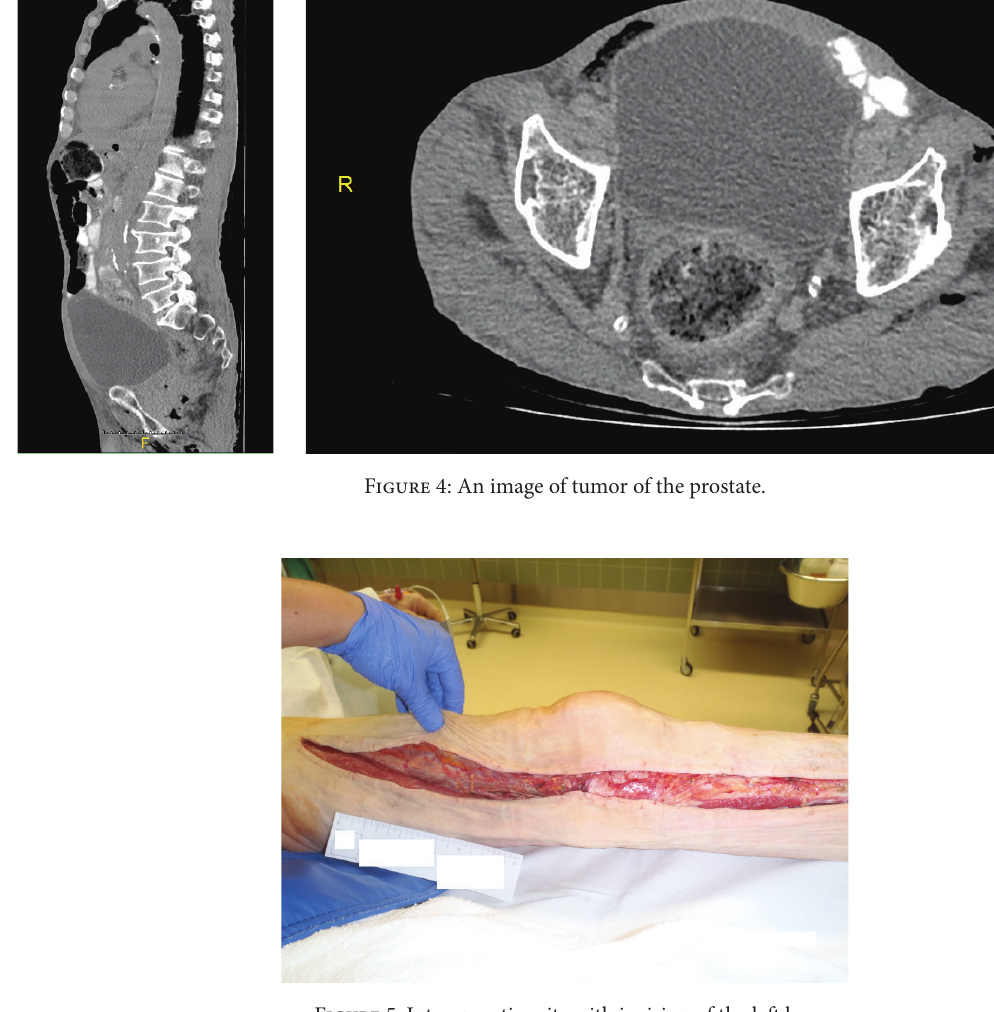
Figure 5: Intraoperative site with incision of the left